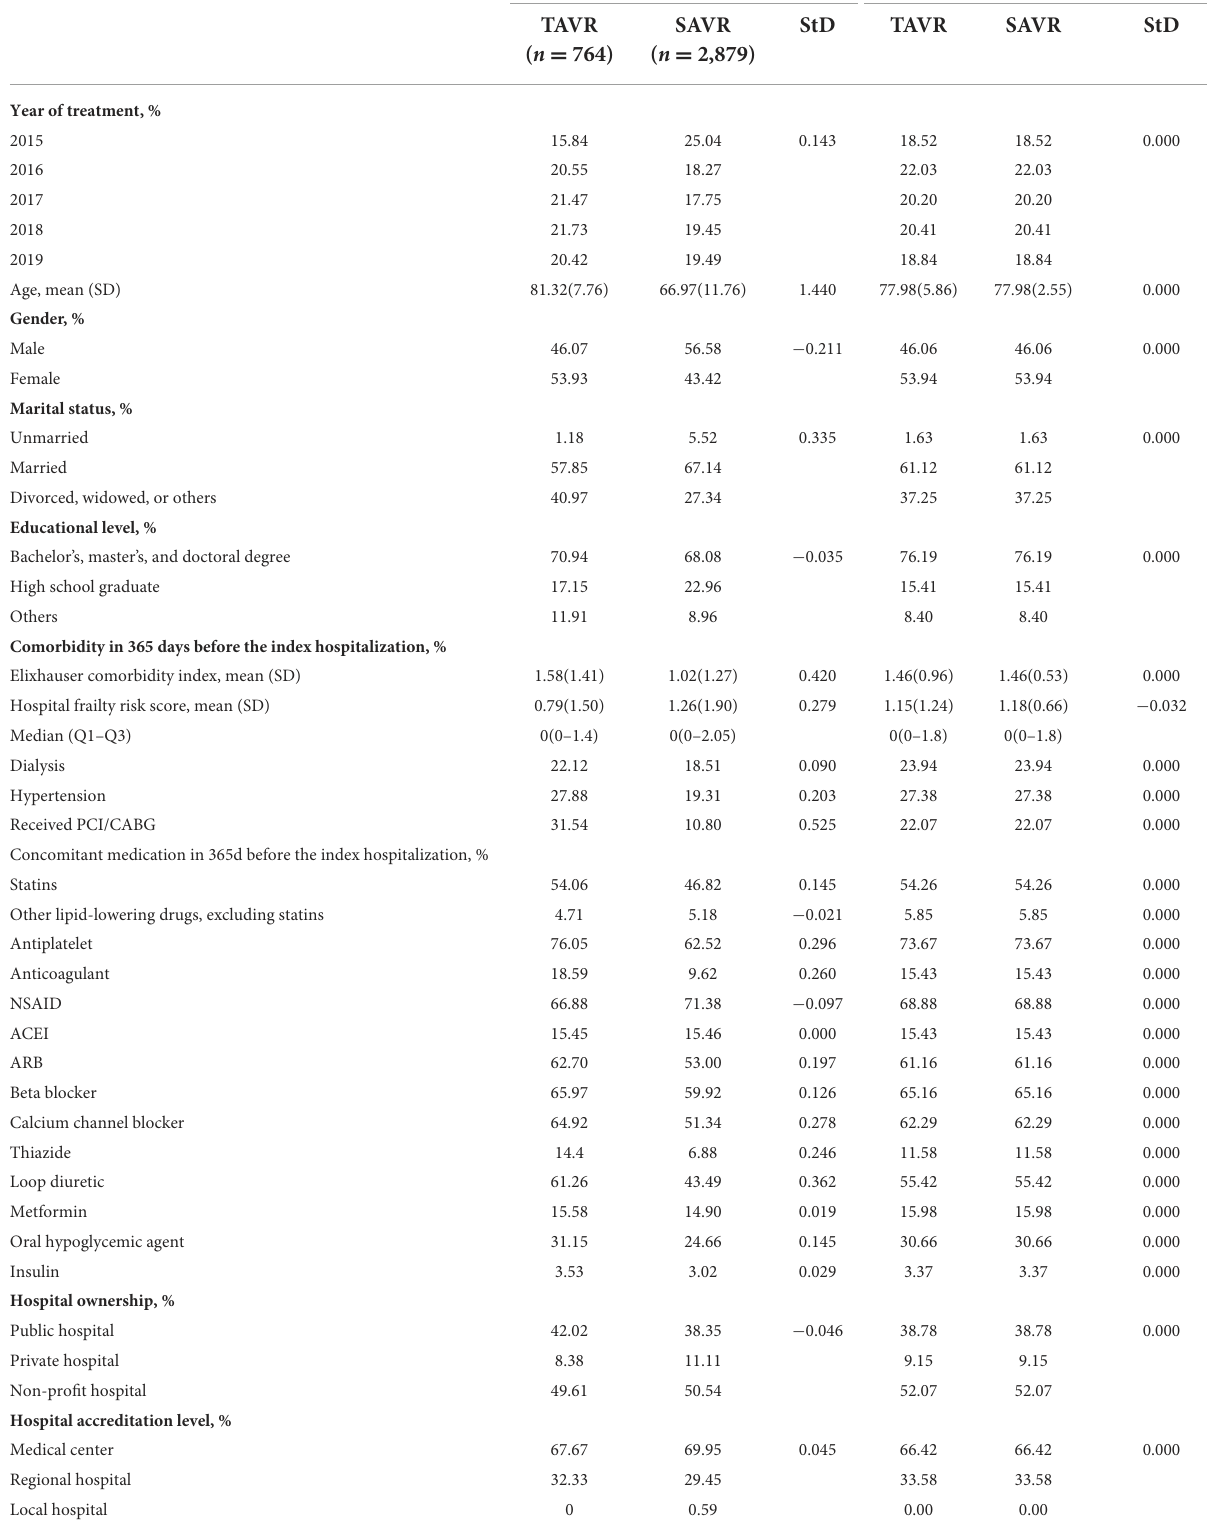
TABLE 1 Baseline characteristics of patients before and after propensity score overlap weighting. Unweighted After propensity score weighting TAVR SAVR StD TAVR